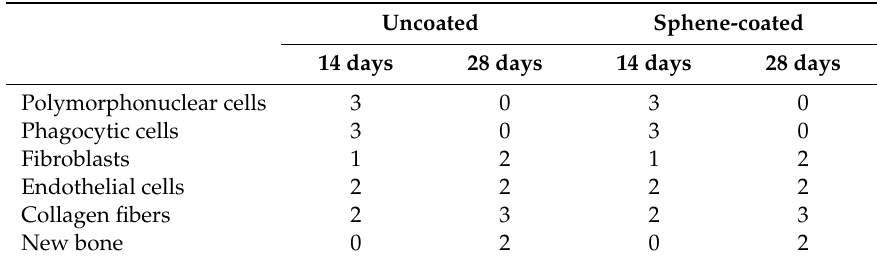
Figure 10. Staining with hematoxylin and eosin (H&E) ( a , c ) and Masson’s trichrome ( b , d ) of the peri-implant tissues around the uncoated ( a , b ) and the sphene-coated implants after 14 days of healing. In both experimental conditions, the inflammatory cells (black arrows) and fibroblasts (white arrows) were detected. A new extracellular matrix (ECM) rich in collagen fibers (red arrows) was observed, as well as the presence of several vessels (white circles). Table 6. Results of the histomorphometric measurements after 14 and 28 days from implantation for the uncoated and the sphene-coated